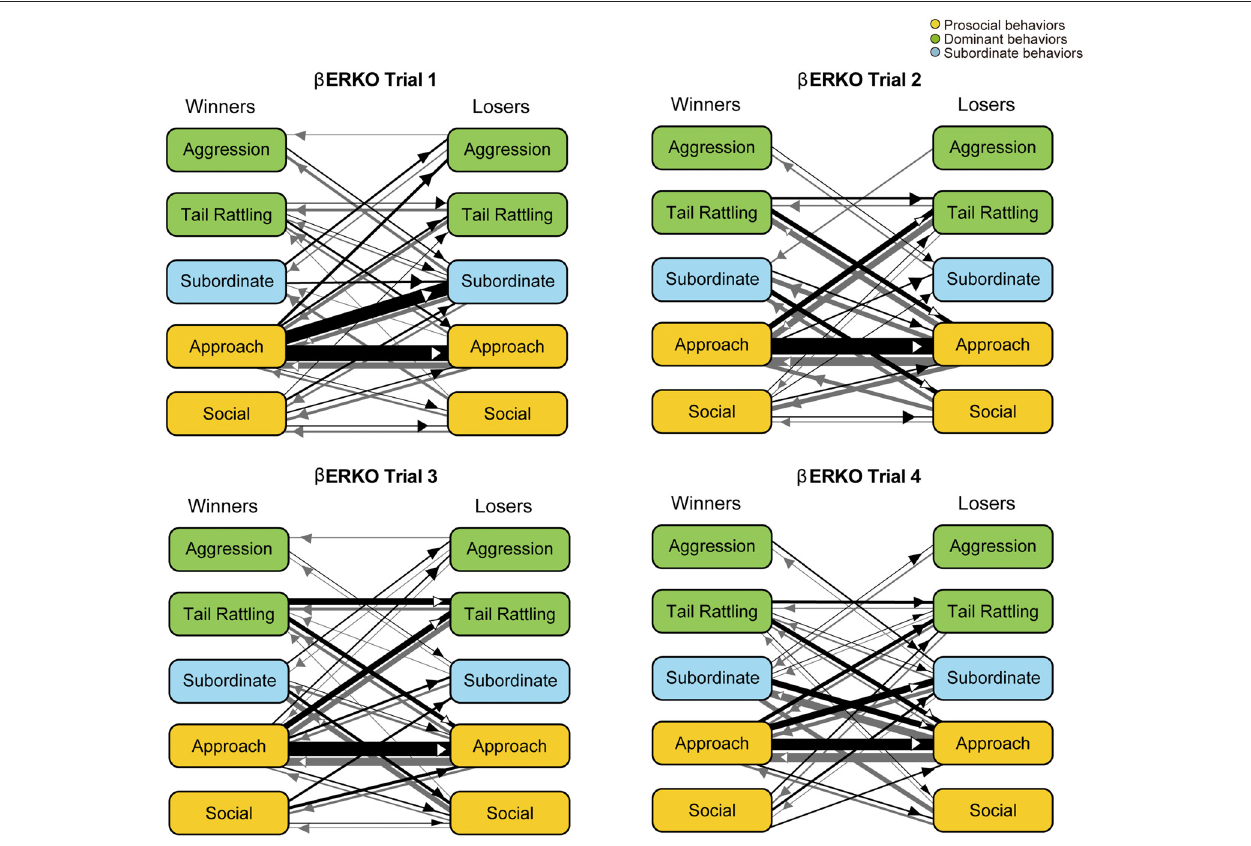
FIGURE 6 | Kinetograms for dyad behavioral transitions of β ERKO pairs in each trial. Width of the arrows were also calculated using the following formula. Arrow width is proportional to (Total number of each transition)/(Total number of all transition within each genotype, trial and initiator). Black arrows indicate dyad transitions initiated by the winners. Gray arrows indicate dyad transitions initiated by the losers.